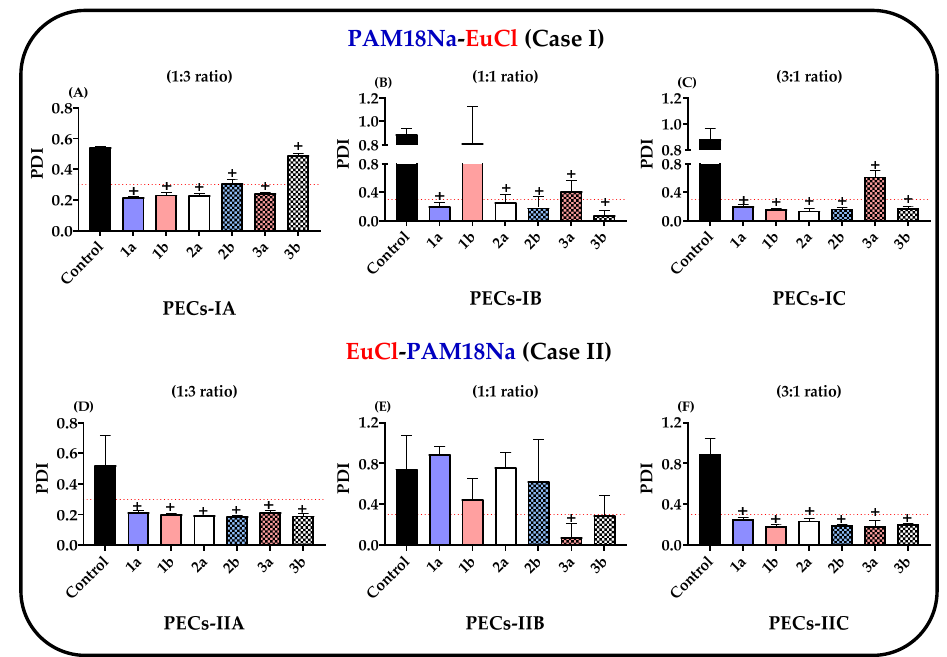
Figure 3. Characterization of the polydispersity index (PDI) for ampicillin-loaded PECs. ( A ) PAM-18Na-EuCl 1:3 ratio. ( B ) PAM-18Na-EuCl 1:1 ratio. ( C ) PAM-18Na-EuCl 3:1 ratio. ( D ) EuCl-PAM-18Na 1:3 ratio. ( E ) EuCl-PAM-18Na 1:1 ratio. ( F ) EuCl-PAM-18Na 3:1 ratio. The control corresponds to polyelectrolyte complexes obtained initially by polyelectrolytic complexation (bottom-up method) and was not subjected to UHPH (top-down method). “+” significant at P < 0.05.